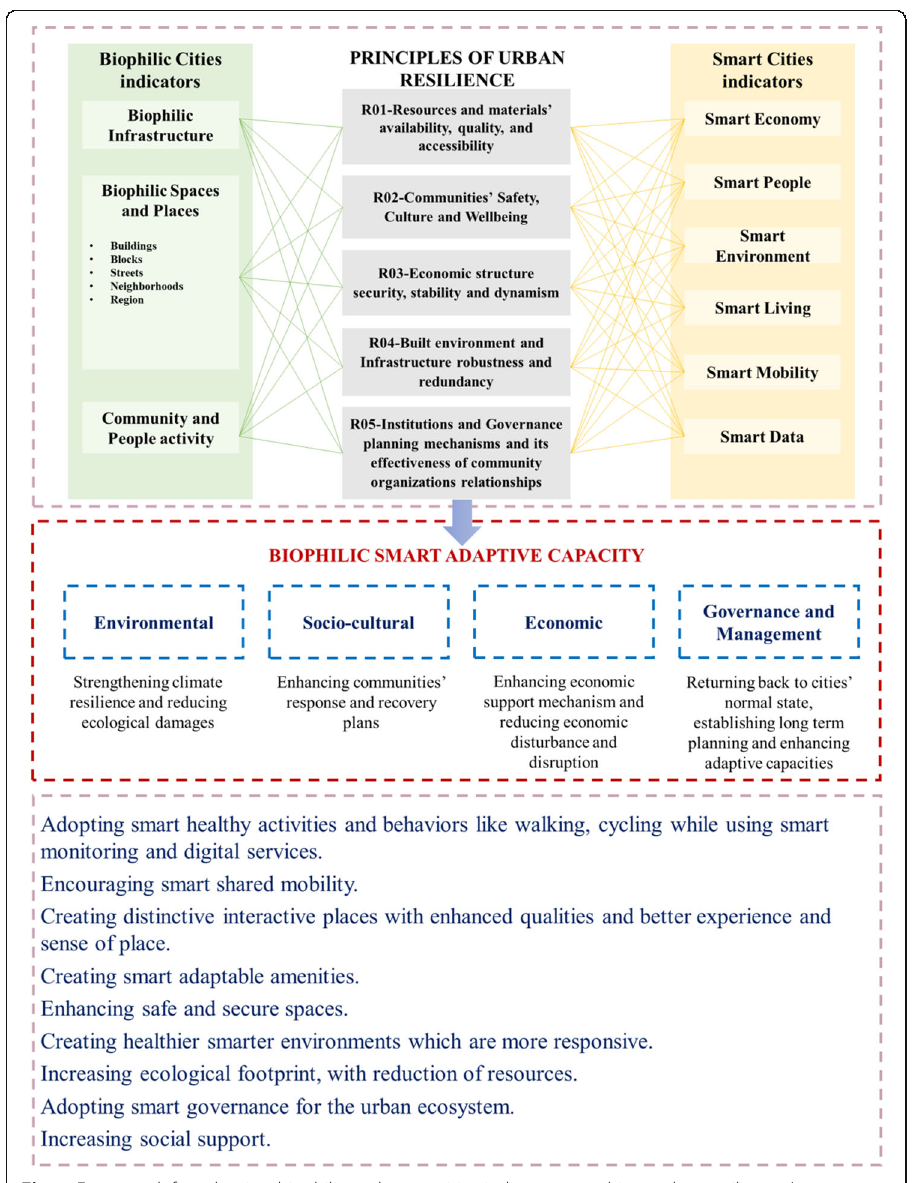
complement to Fig.